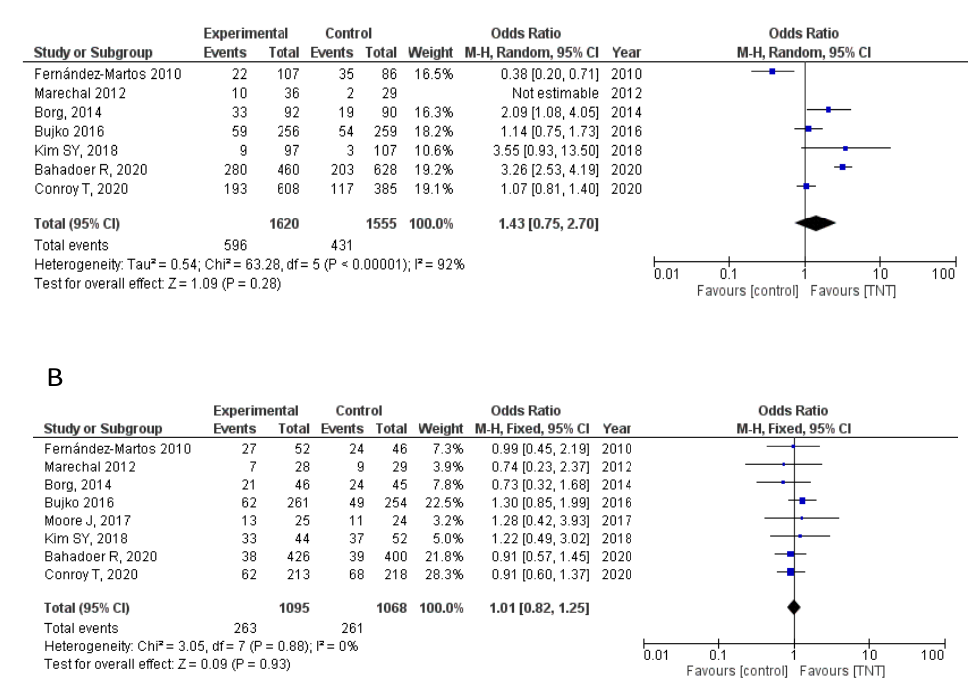
Figure 4. ( A ) Forest plot for G3–4 adverse events. ( B ) Forest plot for G3–4 adverse events due to surgical complications.